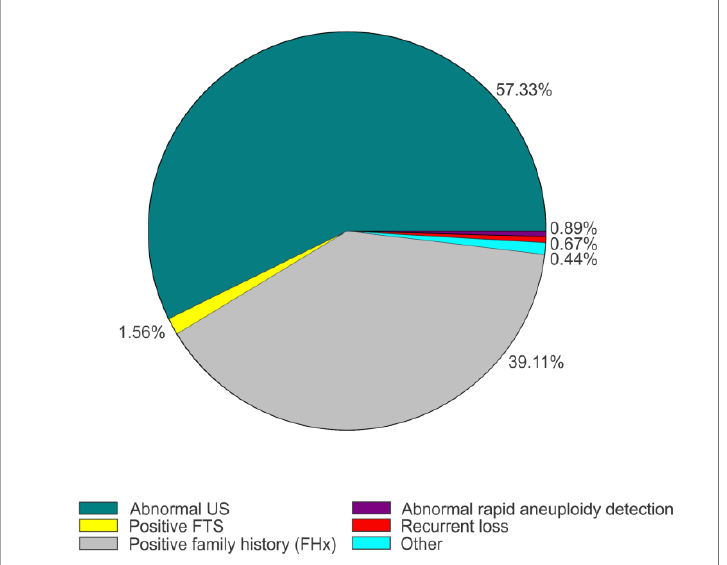
Figure 1. A pie chart representing the proportion of reasons for referral to our clinic between May 2017 and June 2020 with fetal structural abnormalities (57.33%) and positive family history (39.11%) as the common reasons, followed by positive first trimester screen (1.56%), abnormal rapid aneuploidy detection (0.89%), Recurrent Loss (0.67%) and other reasons (0.44%). The average maternal age of cases reviewed was 31 (27–35) years old, and prenatal testing was done at a median gestational age (GA) of 20 weeks. Aside from abnormal ultrasound findings, a total of 136 pregnant women received fetal echocardiography, of which 52 (38.2%; 52/136) were abnormal. Fetal magnetic resonance imaging (MRI) was completed on 51 fetuses and abnormalities were identified in 41 (80.4%; 41/51). A total of 408 fetal records were reviewed. The majority of fetal records were positive for at least one anomaly involving amniotic fluid, head & neck, central nervous system (CNS), thorax, cardiovascular (CV), gastrointestinal (GI), genitourinary, and musculoskele- tal (MSK) systems. Moreover, fetal records indicated that 290 (71.1%) cases had a single organ system involved, whereas 118 (28.9%) of the results showed the involvement of multiple